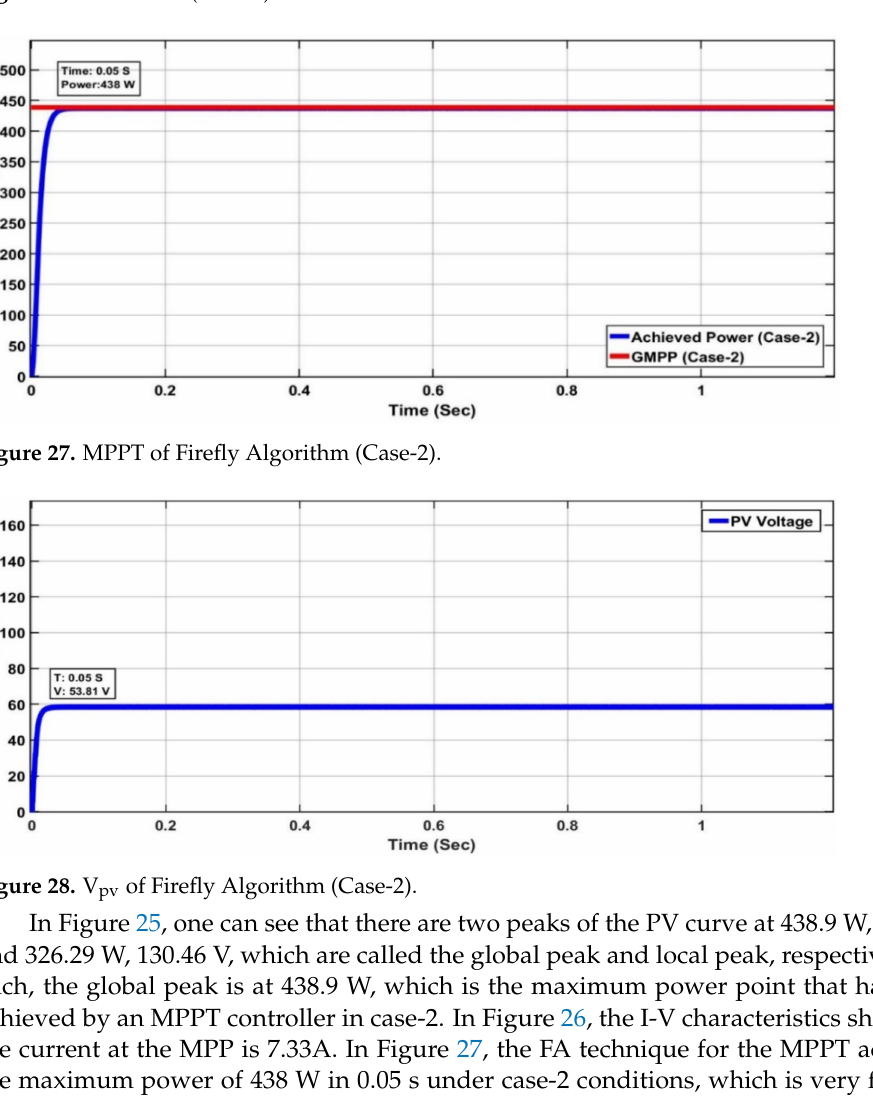
Figure 26. I-V curves (Case-2).